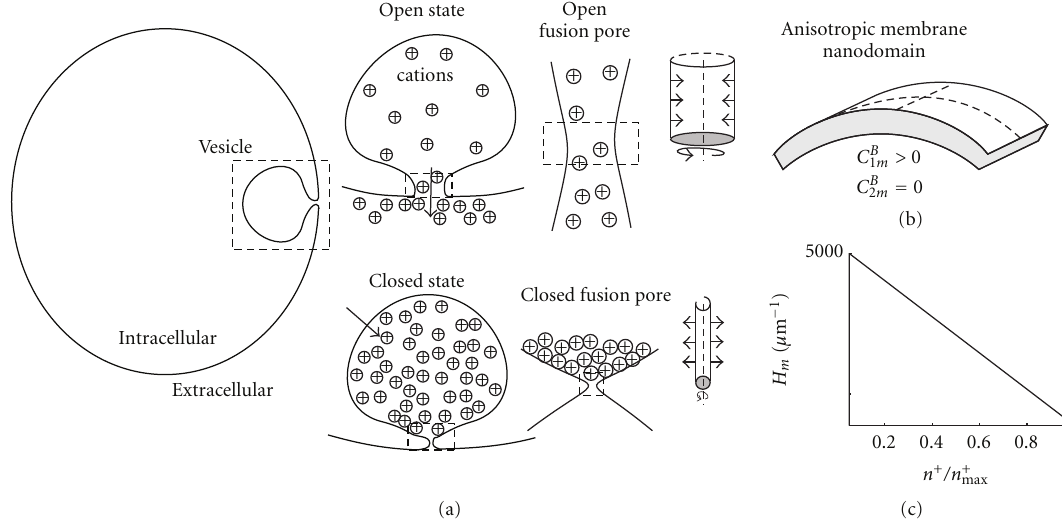
Figure 3: Schematic model for the rhythmic opening and closure of the fusion pore. The stable fusion pore of a vesicle can either be in open or closed states (a). The influx of cations via ion channels in the vesicle membrane is constant, while the e ffl ux through the fusion pore out of the vesicle is allowed only when the fusion pore is open (see insets). The spontaneous curvature at the fusion pore is modulated by the cation concentration in the vesicle. The membrane force, derived from the di ff erentiation of the system free energy, is exerted in the radial direction (see arrows) of the modelled axisymmetric fusion pore (see insets). The fusion pore is composed of a single anisotropic membrane domain (b). The membrane spontaneous curvature ( H m ) of the fusion pore is plotted as a function of the relative cation concentration ( n + /n + (c). The proposed dynamics is that the cation flux through the vesicle increases the cation concentration in the vesicle, which then reduces the intrinsic membrane curvature ( H m ) leading to the opening of the fusion pore. The opening of the pore causes the abrupt reduction in cation concentration, which increases the spontaneous membrane curvature of the pore leading to the abrupt closing of the fusion